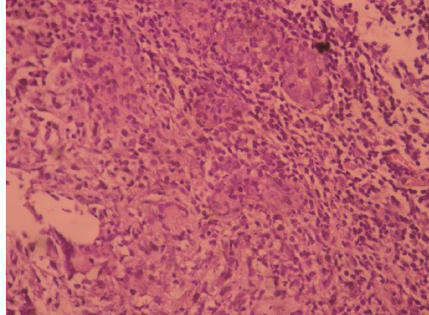
Figure 3: IGM histopathology H-E × 40.